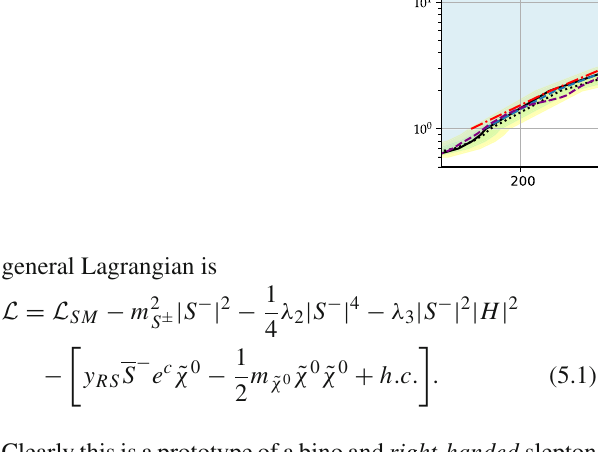
Fig. 4 Limits on winos from both the CMS disappearing track search and ATLAS heavy stable charged particle search. We also show for comparison the exclusion contour from the 36 fb − 1 ATLAS disappearing track search (purple dashed) labelled as “ATLAS